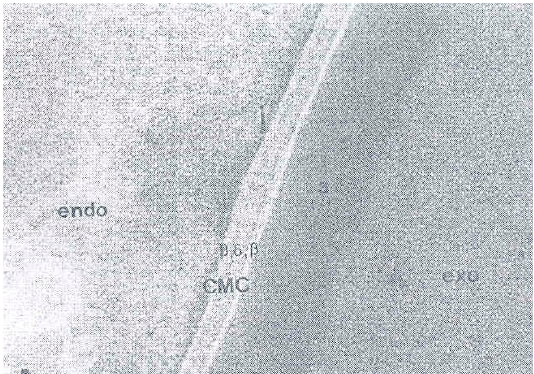
Figure 6. The cell membrane complex between two cuticle cells showing the central dense δ —layer and flanked by the two low density β -layers. From reference [24].